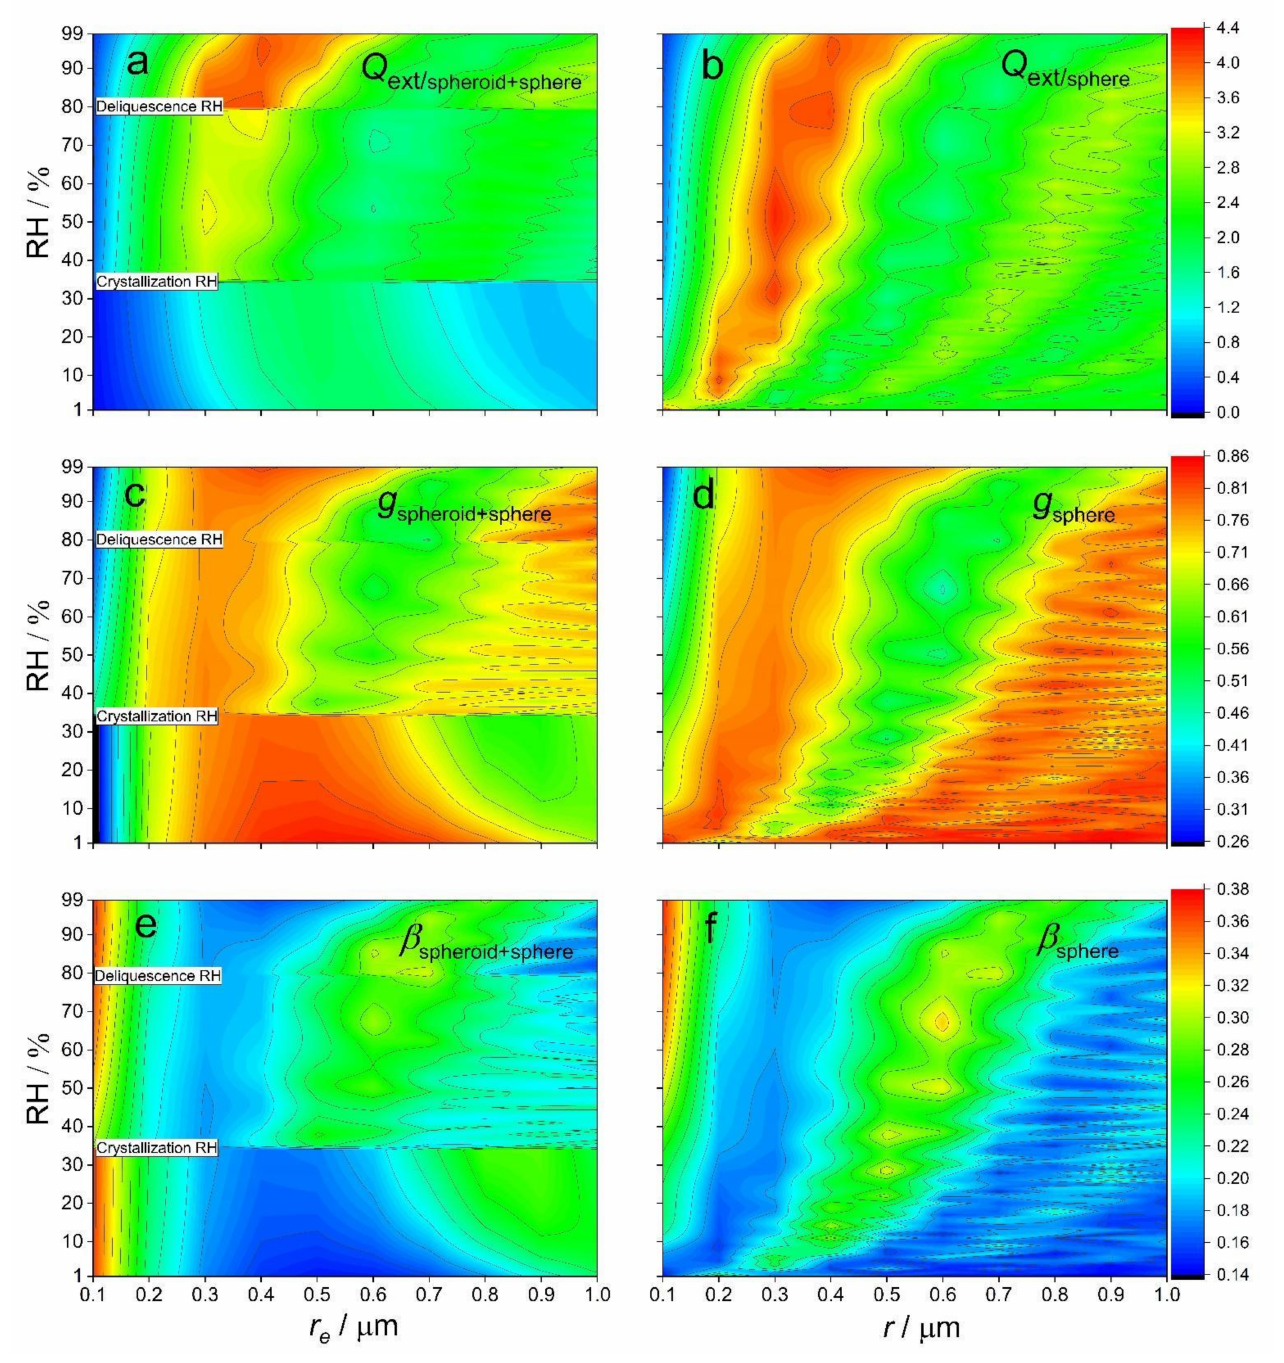
Figure 3. Optical properties ( Q ext , g and β ) from T-Matrix and Mie simulations ( a , c , e ) and only from Mie predictions ( b , d , f